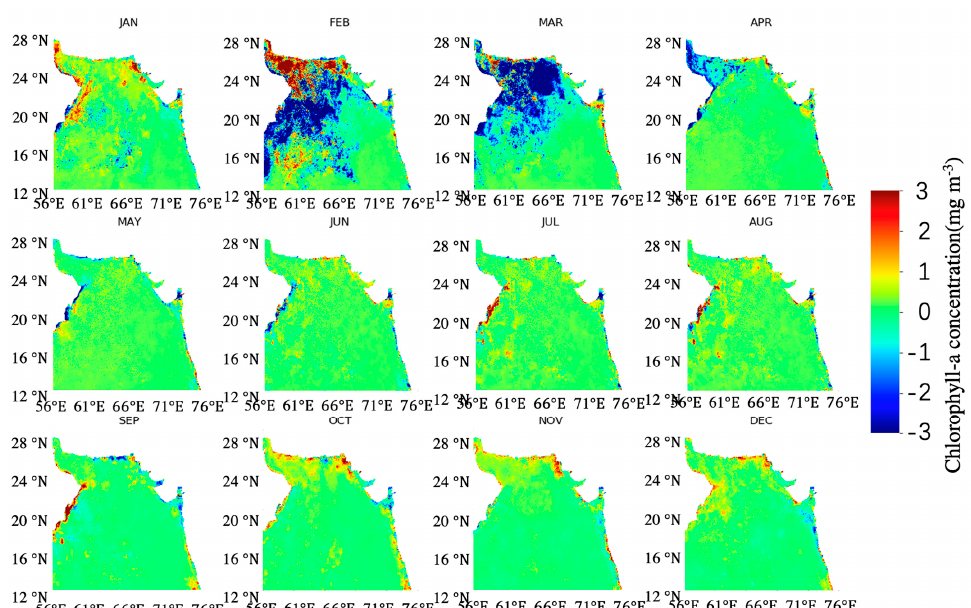
Figure 13. Difference in monthly interpolation results for Chl–a obtained with DINCAE–BME from January to December, generated by subtracting 2020 results from 2021 results in months.